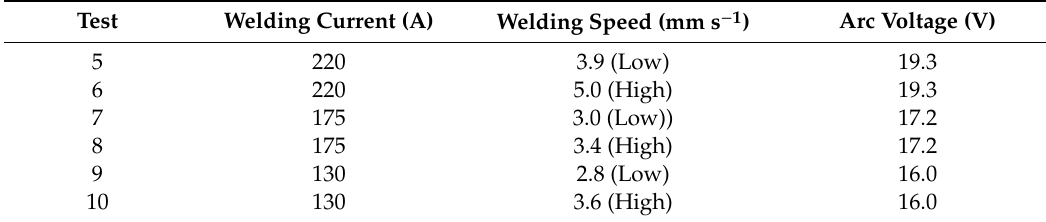
Table 6. Factorial design 2 k (welding